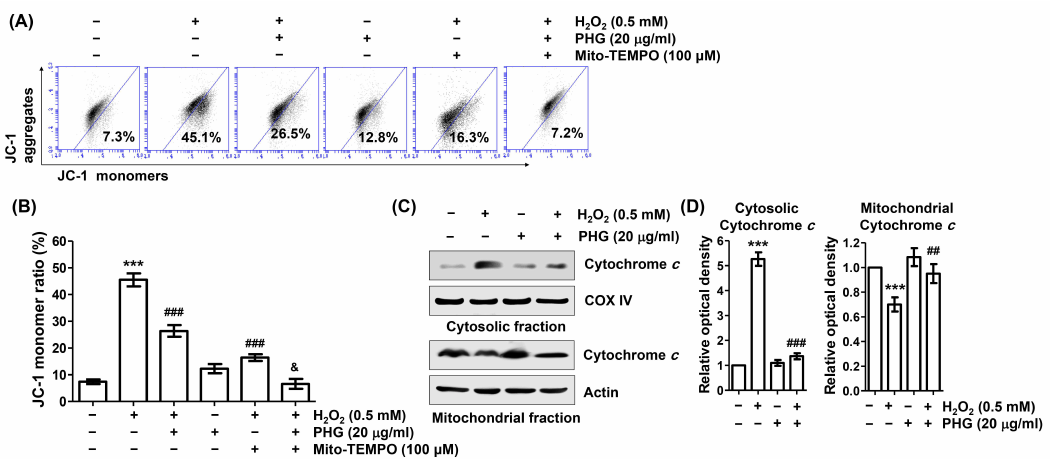
Figure 6. Phloroglucinol protects H 2 O 2 -induced mitochondrial impairment and cytosolic release of cytochrome c in ARPE-19 cells. Cells were preincubated with or without phloroglucinol and/or Mito-TEMPO for 1 h, followed by treatment with H 2 O 2 for another 24 h. ( A , B ) After with 5,5 (cid:48) ,6,6 (cid:48) - tetrachloro-1,1 (cid:48) 3,3 (cid:48) -tetraethyl-imidacarbocyanune iodide (JC-1) staining, representative histograms ( A ) and average values of JC-1 monomer ratios ( B ) are presented. ( C ) After isolation of mitochondrial and cytoplasmic fractions, the expression of cytochrome c in each fraction was investigated by immunoblotting. ( D ) Bar diagram showing the relative protein density after normalization with actin based on Western blot analysis. *** p < 0.001 vs. unstimulated control; ## p < 0.01 and ### p < 0.001 vs.